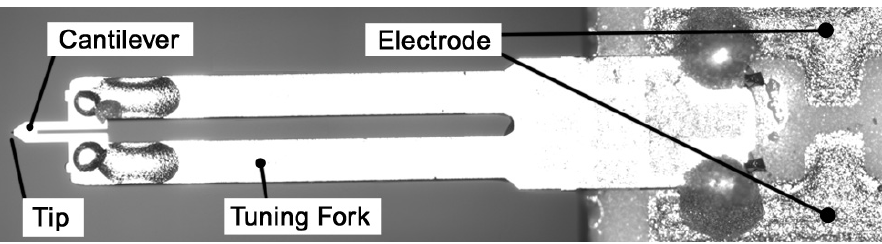
Figure 3. The photograpgy of tuning fork